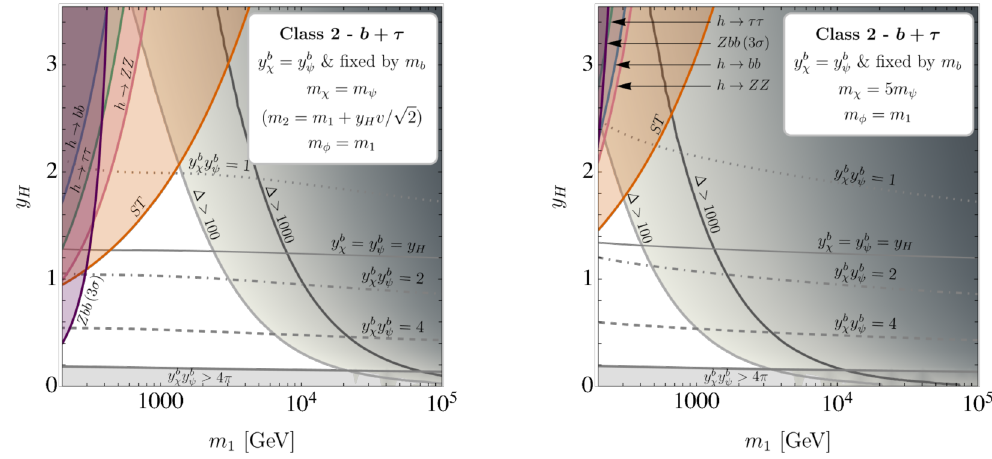
Figure 14. Theoretical (grey) and current 2 σ experimental constraints (coloured) on the Class 2 combined b + τ benchmark